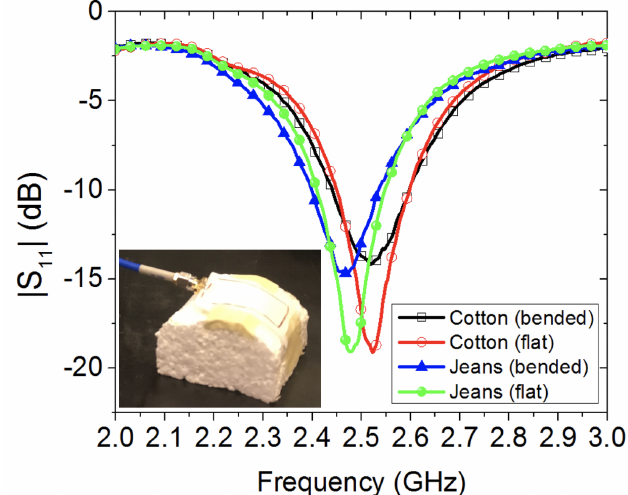
Figure 9. Experimental study of the effect of bending two wearable loop antenna prototypes, on a semi-cylindrical foam